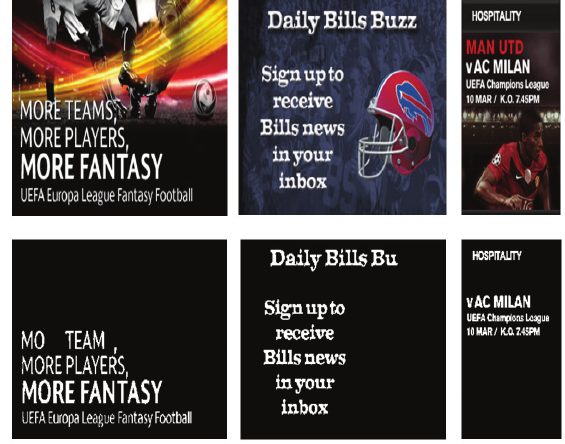
Figure 9: Failure cases on ICDAR2013